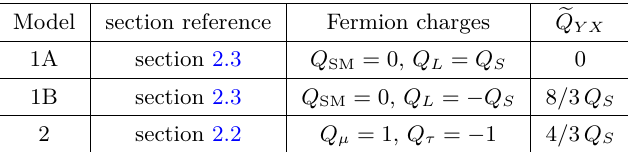
Table 1 . The effective charge e Q Y X , introduced in eq. (B.14) of appendix B, determines the fixed- point value of kinetic mixing for the three scenarios considered in this